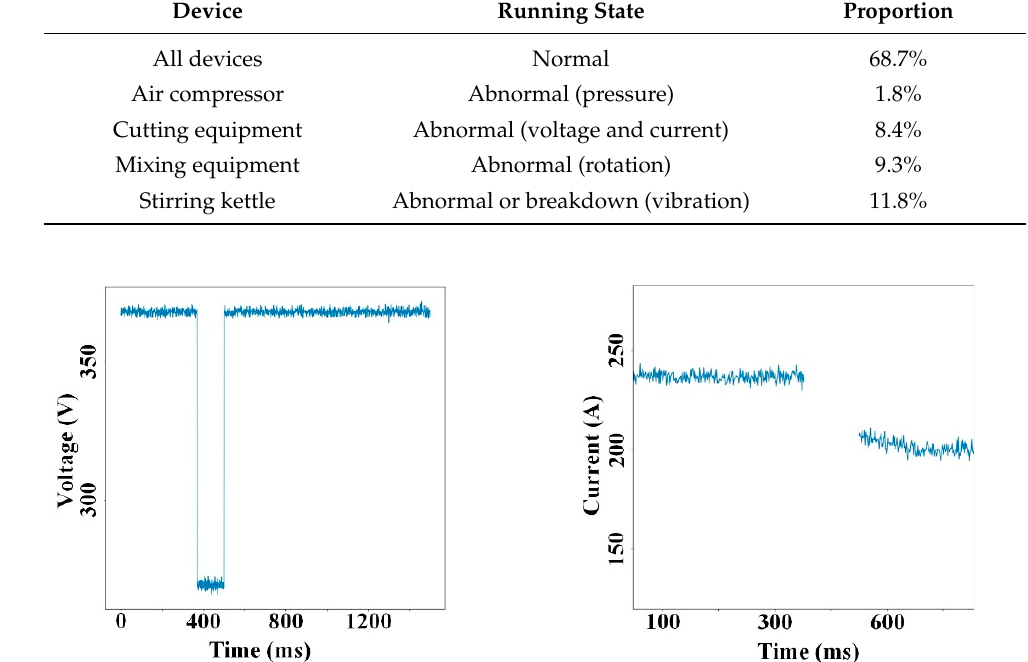
Figure 7. The preprocessed dataset of multi-sensor signals. Subplots ( a – f ) are signals of voltage, current, rotation, vibration-x, vibration -y and pressure, respectively. Subplots ( a , b ) refer to the start- ing moment, and subplots ( c – f ) reflect the normal running state of corresponding equipment. Training. Adam was selected as the optimizer with a momentum of 𝛽 (cid:2869) = 0.95 , 𝛽 (cid:2870) = 0.997 in the training process. Batch size was fixed to 128, and the learning rate was 0.0002 at the beginning. The decay ratio of learning rate was 0.98 per five epochs; hence, the final learning rate was 2𝑒 (cid:2879)(cid:2872) × 0.98 (cid:2872)(cid:2868) ≈ 8.9𝑒 (cid:2879)(cid:2873) . In the training process, the changes of mean square error (MSE) loss of the training and testing set are shown in Figure 8. In the first 30 epochs of training, the mean square error loss of the training set and test set showed a rapid decreasing trend, but after epoch 160, the decreasing trend became slower. As can be seen from Figure 8, in the training and testing set, MSE loss after training of epoch 180 are both minimum values. To select the model with the best performance, the model pa- rameters after epoch 190 of training were selected as the final CNN-LSTM model param- eters. At this time, the MSE loss of the training and testing set were about 0.4227 and 0.4213, respectively.